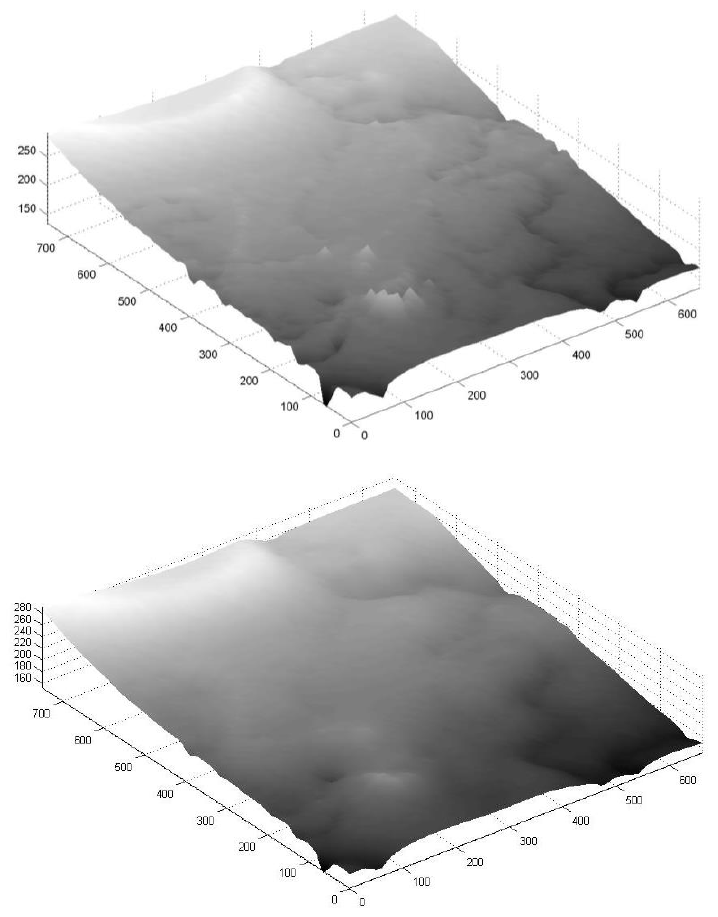
Figure 7. 3D visualization of the 10 m resolution DTM for Technion area: pre-Kalman filter ( top ), and post-Kalman filter ( bottom ) (all values in meters).